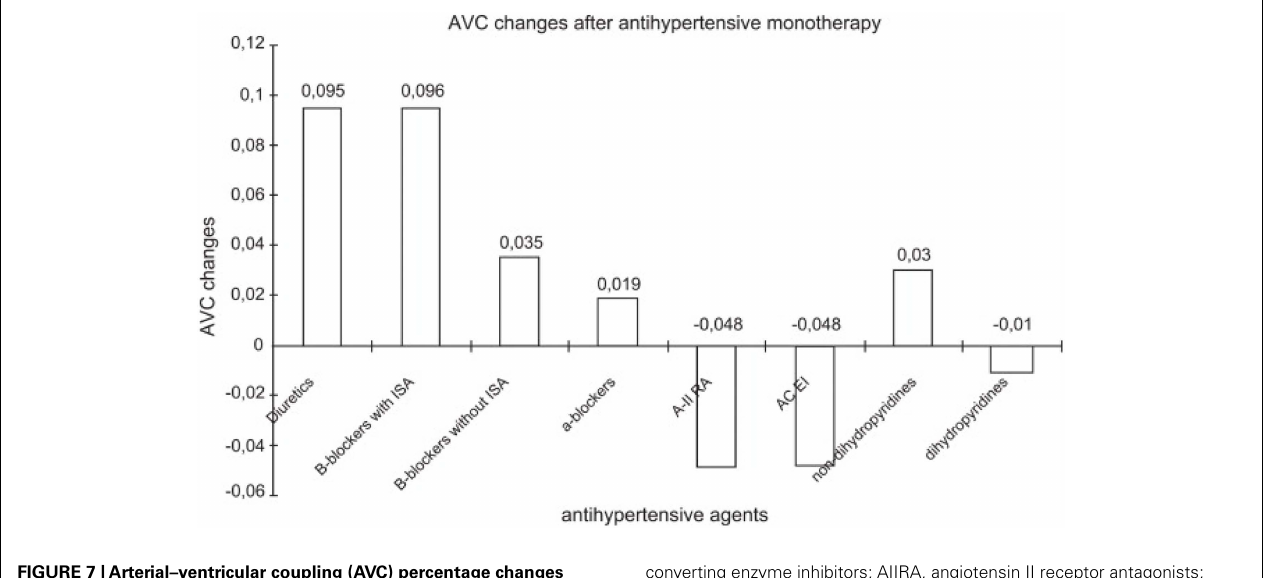
FIGURE 7 |Arterial–ventricular coupling (AVC) percentage changes after antihypertensive monotherapy in 10,670 patients over 6months of treatment. Abbreviations: ACE inhibitors,